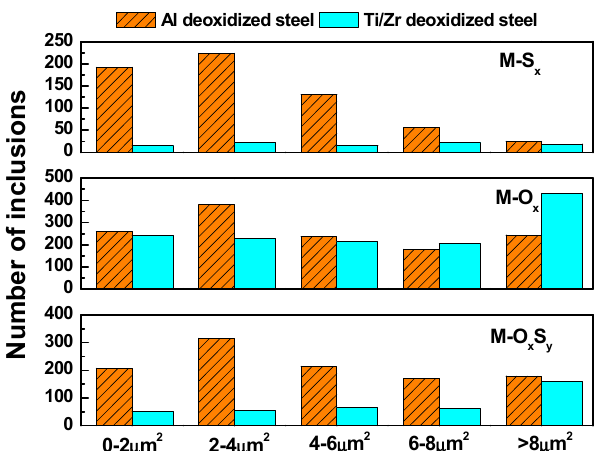
Figure 5. Size distributions of different kinds of inclusions in Al deoxidized steel and Ti/Zr deoxidized steel in a 30 mm 2 scanning region.